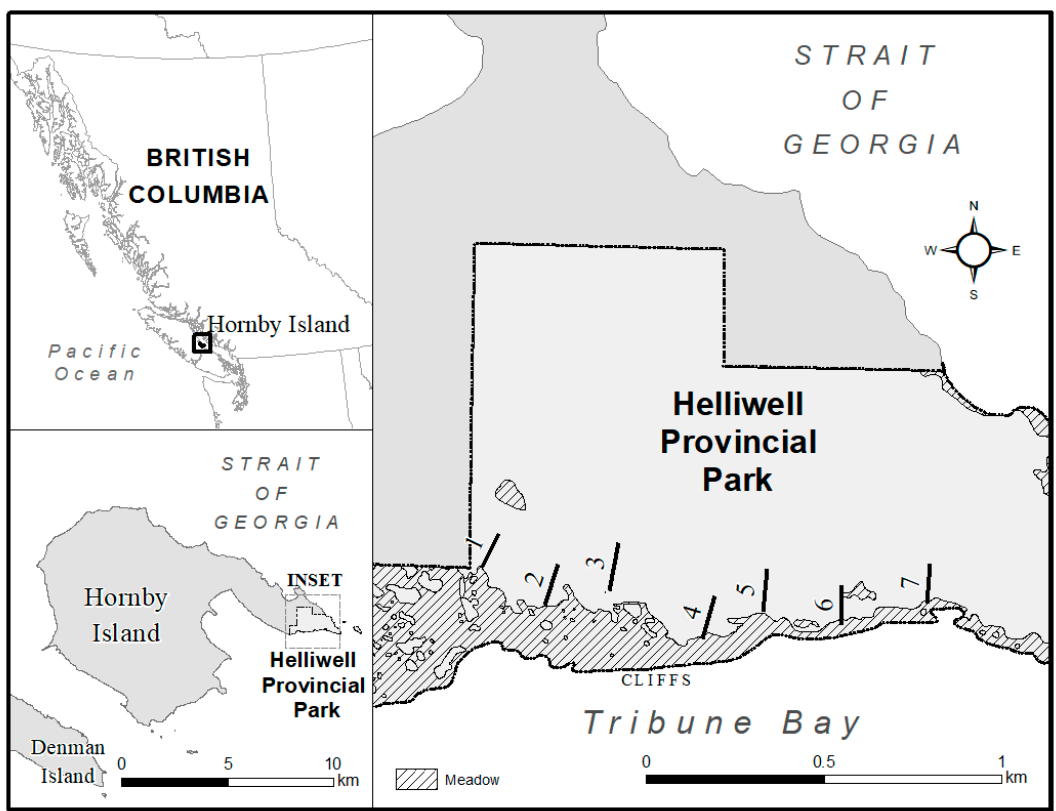
Figure 1. The location of seven 6 × 75 metre belt transects on the southwest portion of Helliwell Provincial Park located on Hornby Island, British Columbia, Canada.